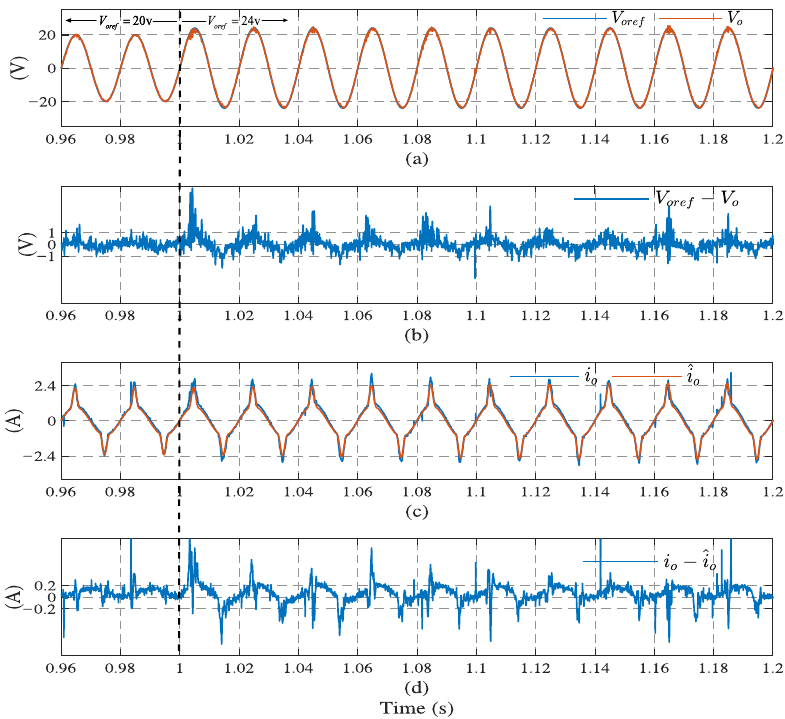
Figure 14. System dynamic response results using observer under nonlinear load: ( a ) output voltage, ( b ) voltage tracking error, ( c ) load current, and ( d ) current estimation